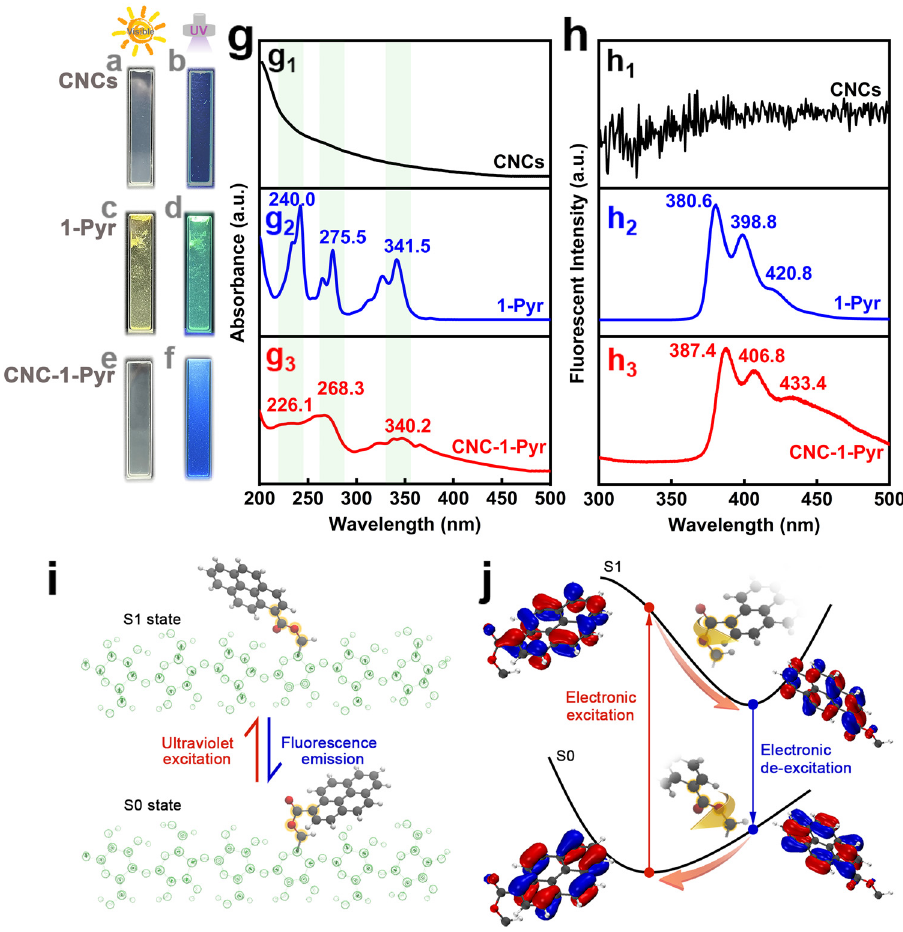
Figure 2: Fluorescence emission of CNCs, 1 - Pyr, CNC - 1 - Pyr, and excited - state geometry relaxation in CNC - 1 - Pyr: ( a – f ) digital photos of ( a and b ) CNCs, ( c and d ) 1 - Pyr, and ( e and f ) CNC - 1 - Pyr under ( a, c, and e ) natural light or ( b, d, and f ) UV light. ( g ) UV - vis spectra and ( h ) fl uorescence emission spectra of ( g ) CNCs, ( g ) 1 - Pyr, and ( g ) CNC - 1 - Pyr. ( i ) Stable conformation of CNC - 1 - Pyr in S0 1 and h 1 2 and h 2 3 and h 3 and S1 state. ( j ) Transformation of electronic and molecular structures along S0/S1 potential energy surface during excitation, relaxation, and de -